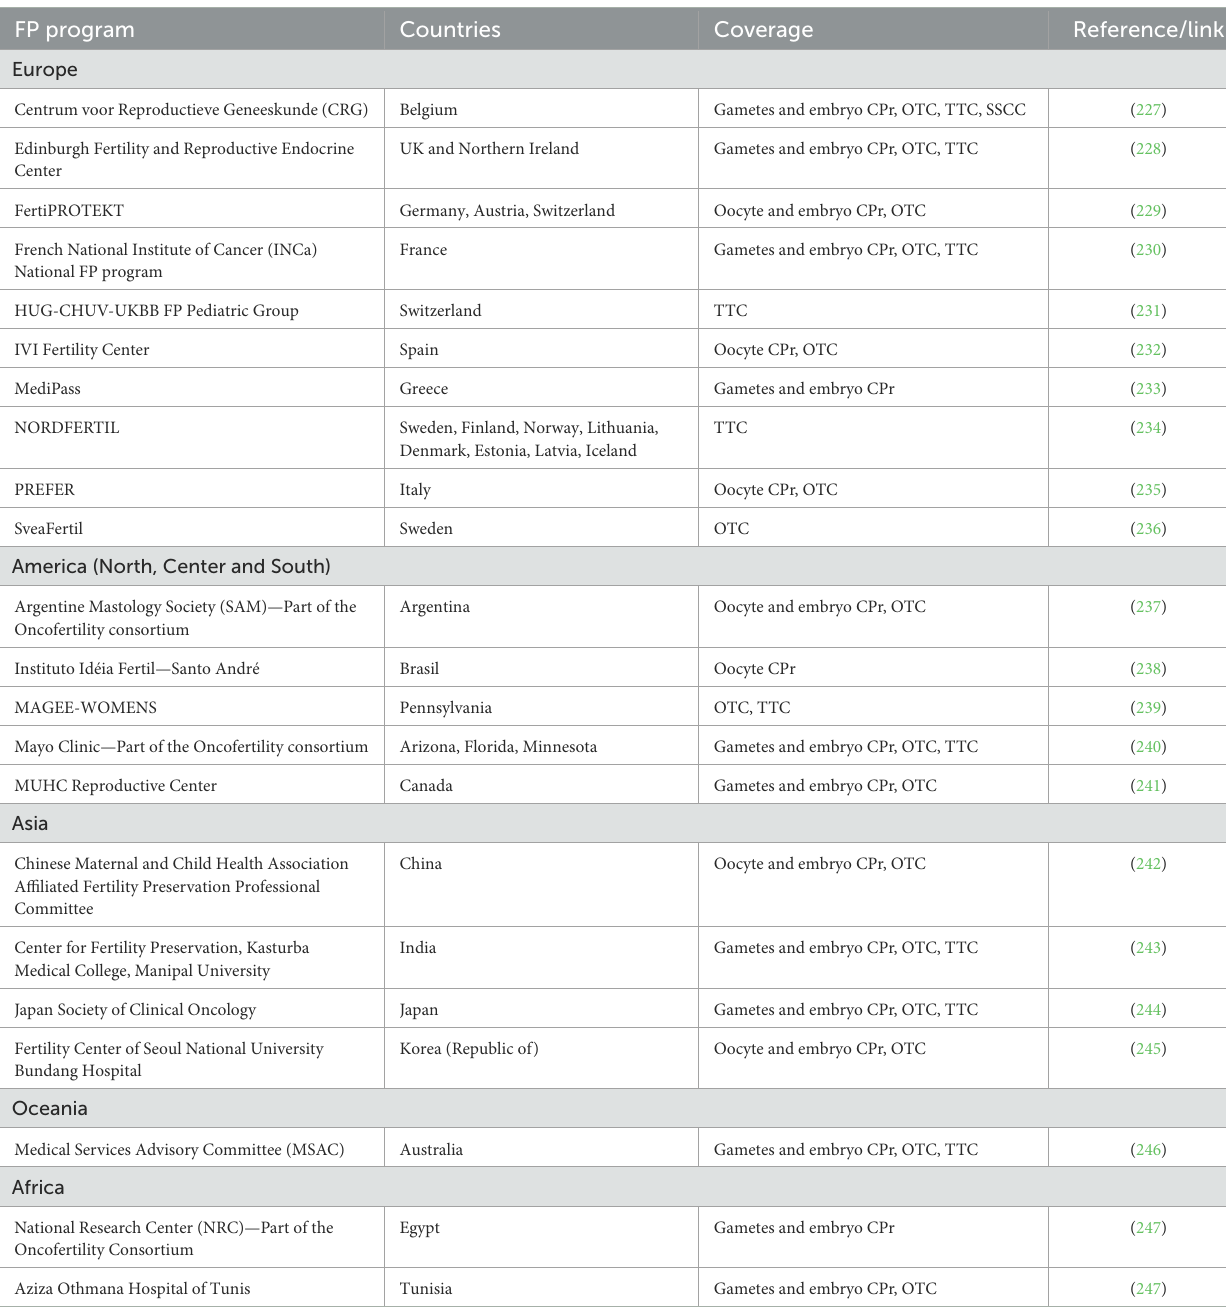
TABLE 2 Recommendations for fertility preservations